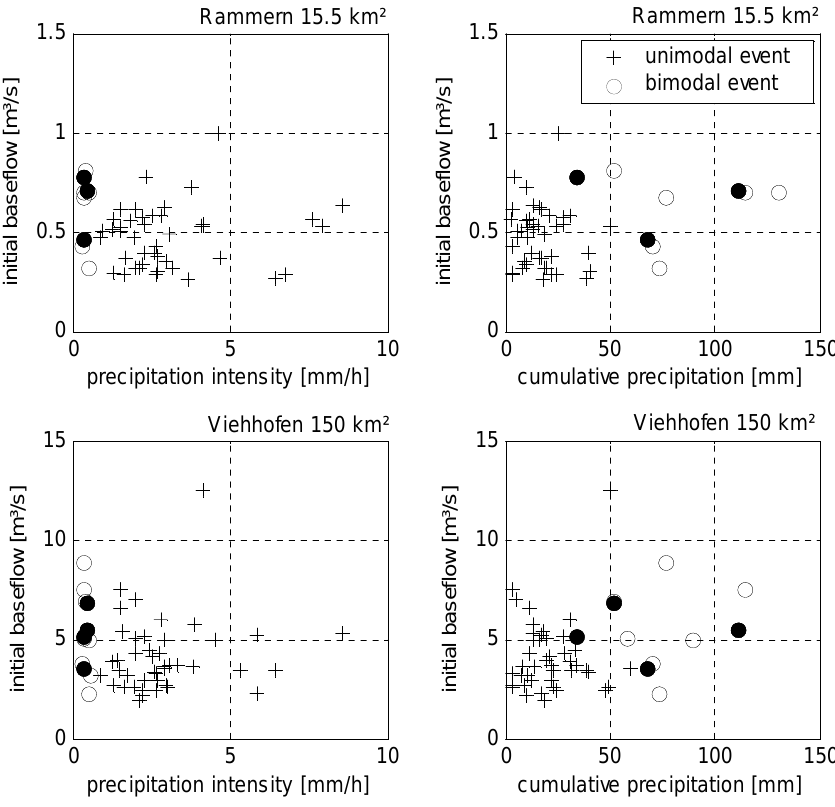
Fig. 12. Initial base flow versus cumulative precipitation, and initial baseflow versus precipitation intensity, for gauges Rammern and Viehhofen. Filled circles indicate bimodal events with underestimated precipitation due to measurement errors.